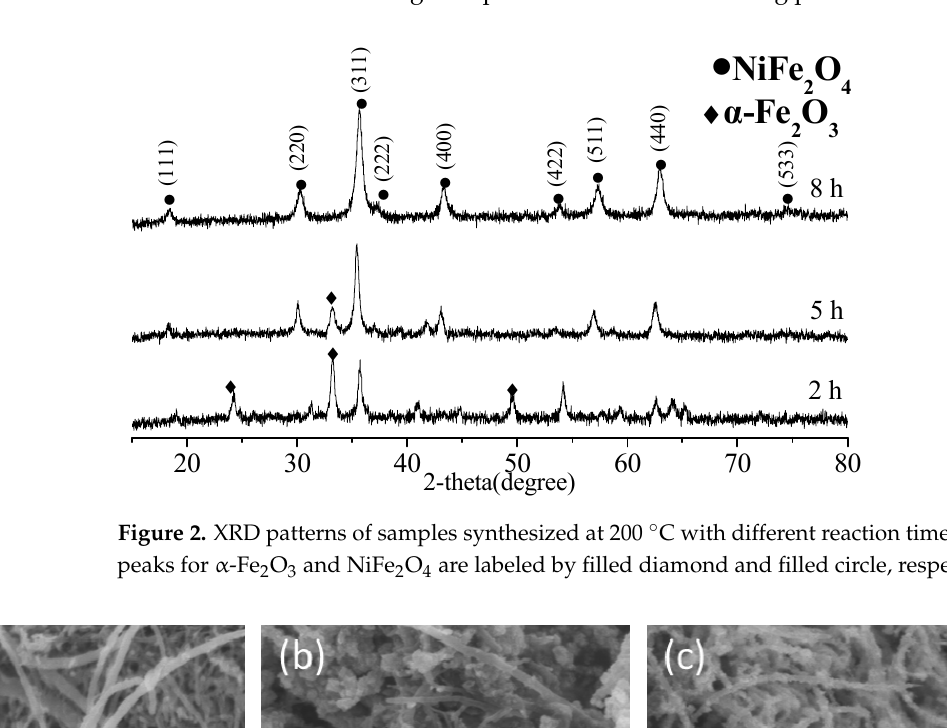
Figure 2. XRD patterns of samples synthesized at 200 °C with different reaction time. Characteris-